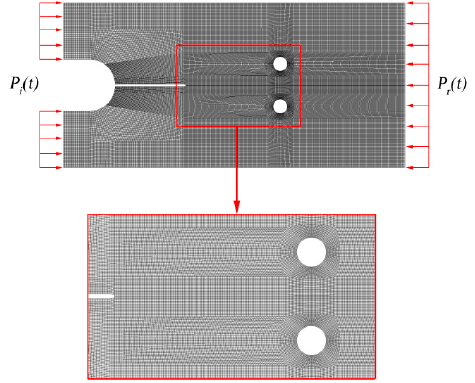
Figure 7. Mesh of the ISCSC specimen.